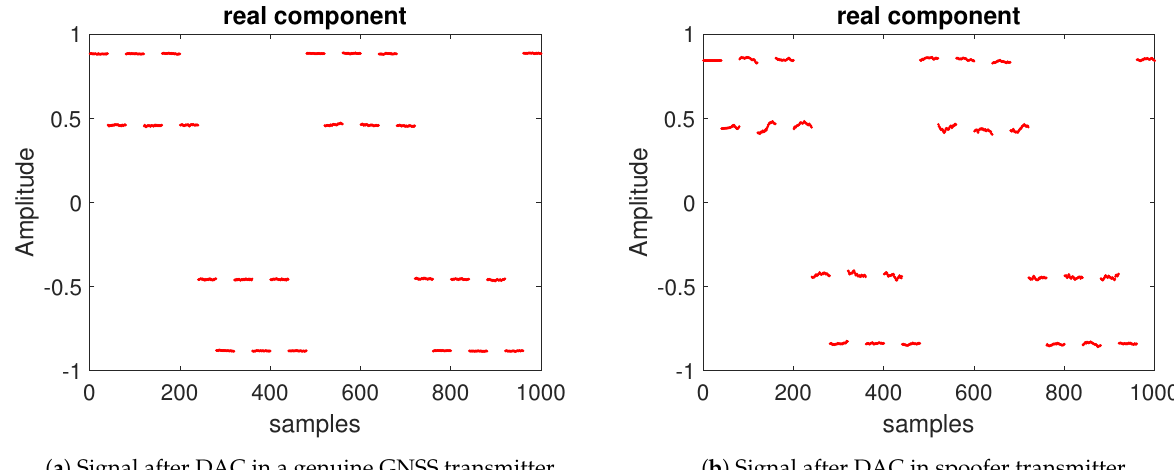
Figure 5. Examples of DAC characteristics at the transmitter, for a genuine ( a ) and a spoofer ( b )